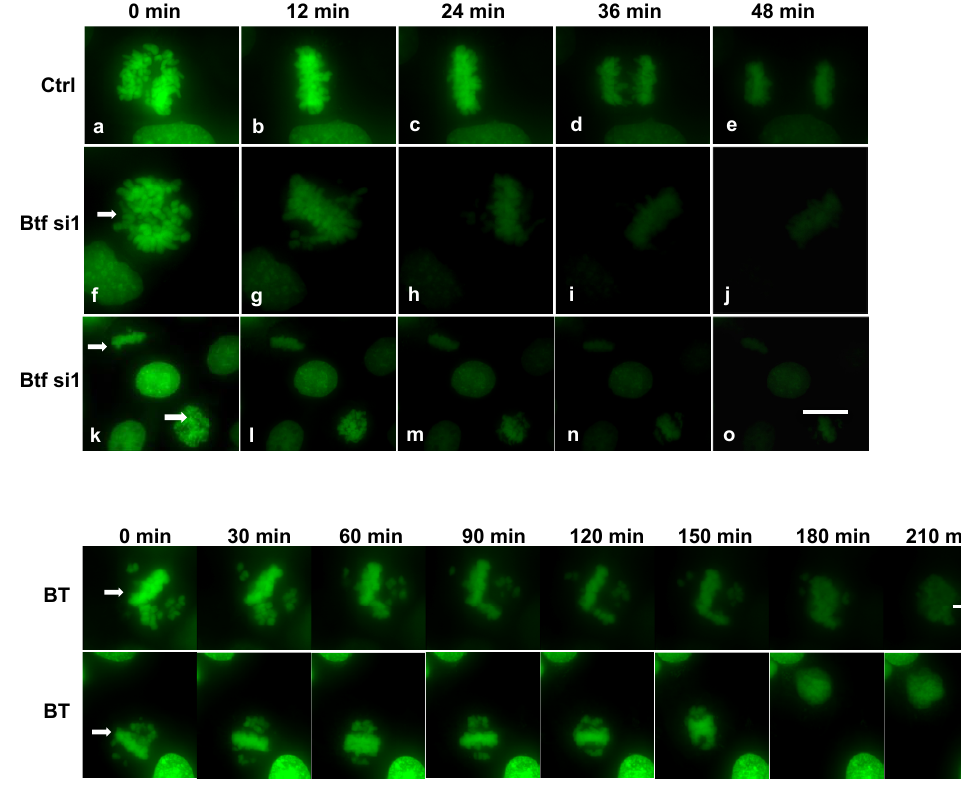
Figure 6. Live imaging of mitotic cells following Btf or Btf and TRAP150 depletion. Time-lapse imaging of HeLa cells stably expressing H2B-YFP initiated 72 h post siRNA transfection with control siRNA ( a – e ) or Btf si1 (one example shown in ( f – j ) and two additional examples in ( k – o )) or BtfSi1 and TRAP150si4 (BT). Cells having chromosome misalignment defects upon reaching metaphase are indicated with arrows. Scale bar = 5 µm.